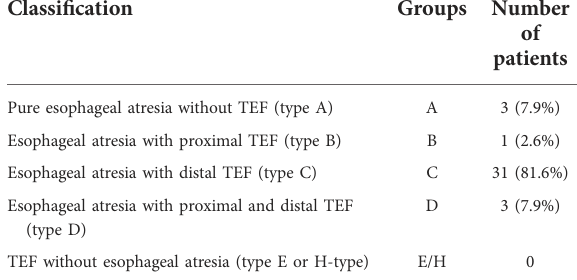
TABLE 4 Distribution of anatomic fi ndings using the Gross classi fi cation